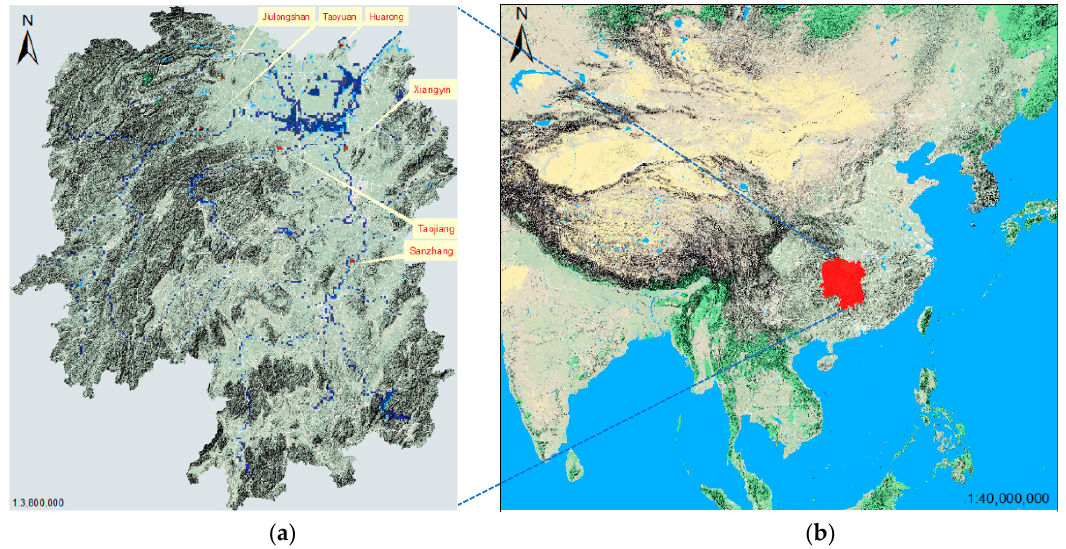
Figure 2. Alternative locations of inland NPPs in Hunan province. ( a ) The locations of inland NPPs; ( b ) The location of Hunan.